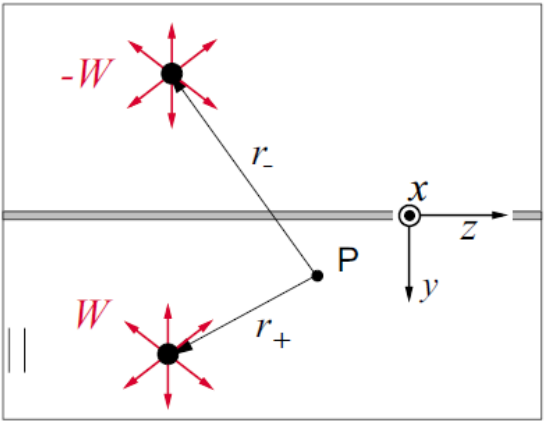
Figure 1. Point source with heat emission W , reflected at the soil surface.